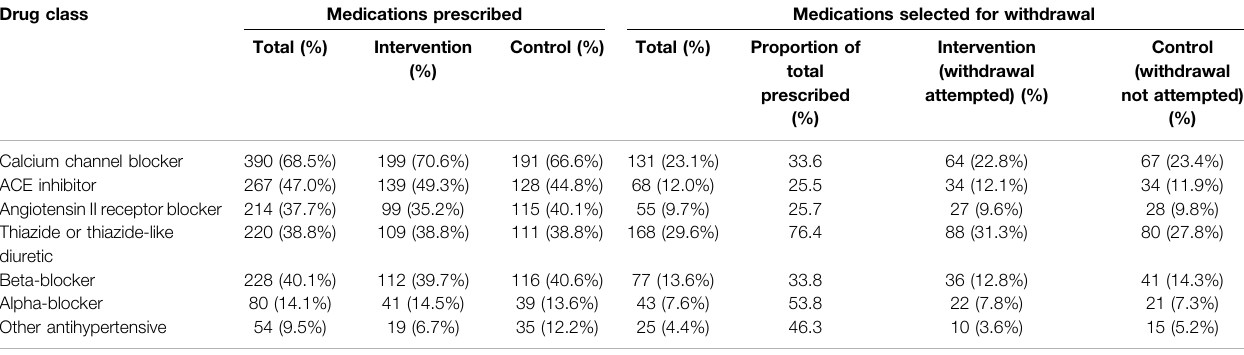
ACE (cid:2) angiotensin converting enzyme.